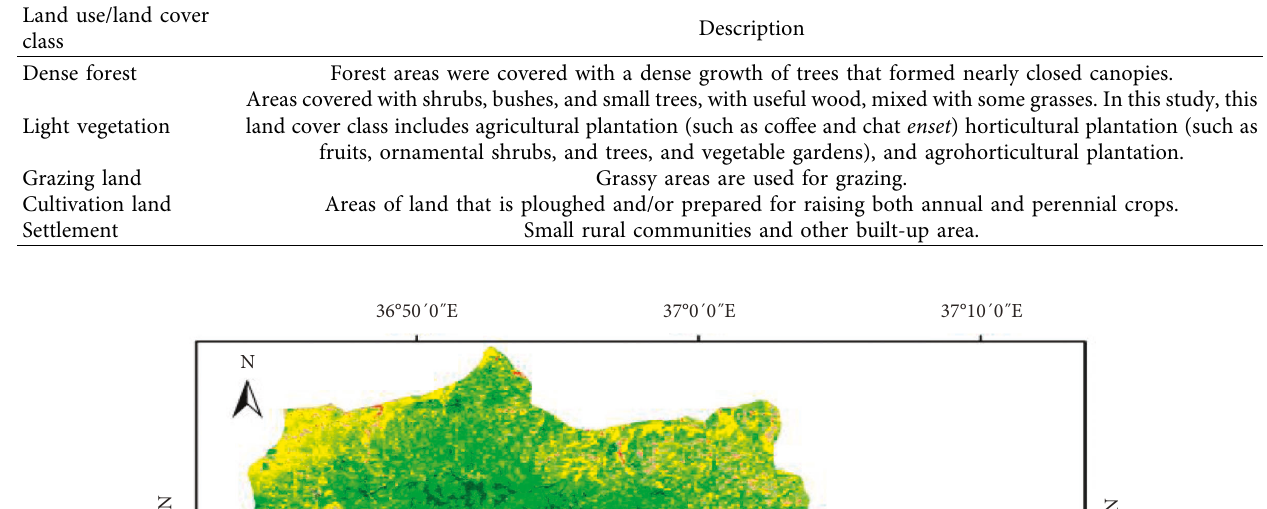
Table 1: Description of land use and land cover classes found in the study area.